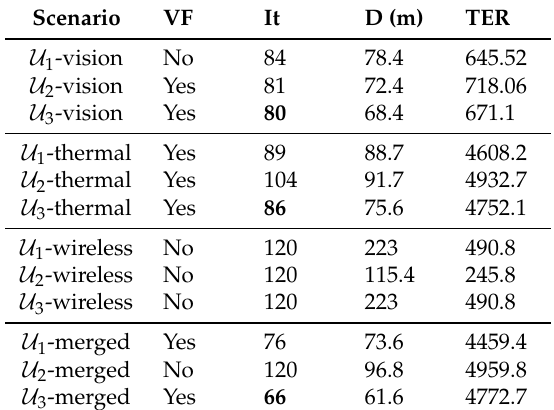
Table 6. Results of AGSA tests. VF: victim Found It: Iterations, D: Distance, TER: Total Entropy Reduction. The numbers in bold indicate better